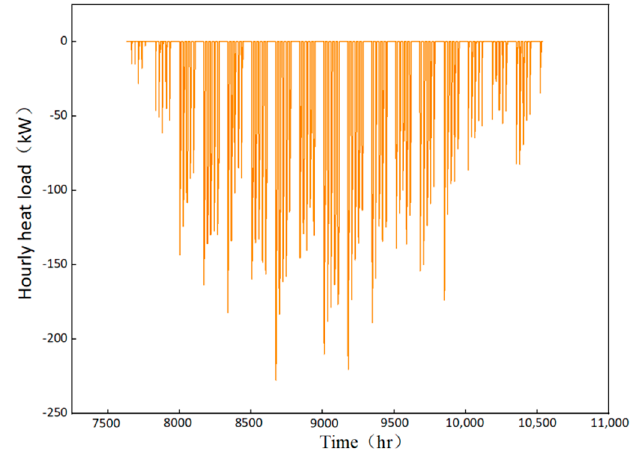
Figure 3. Office and ambient temperature during the heating season.